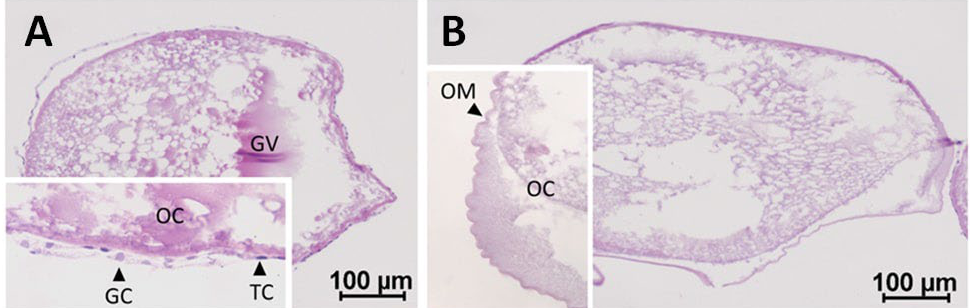
Figure 2. Maturing oocytes in European eel: ( A ) folliculated; ( B ) defolliculated oocytes. The insets zoom in on parts of the section. OC, oocyte; GV, germinal vesicle; OM, oocyte membrane; TC, theca cells; GC; granulosa cells.